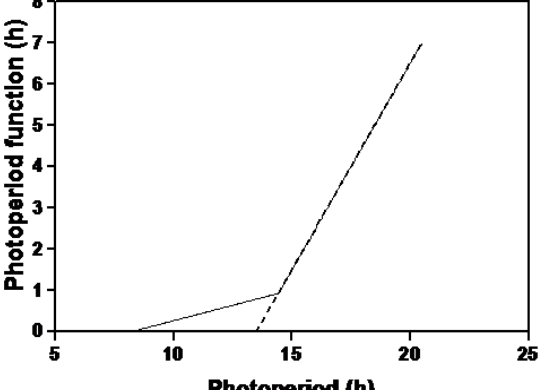
Figure 5. The original one-line photoperiod function (broken line) and the modified two-line function (solid line) which was used in this study for modeling soybean flowering